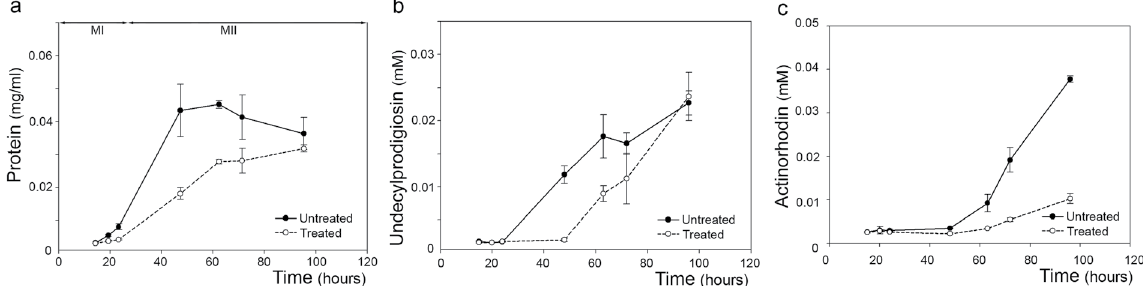
Figure 3. Effect of 5-aza-dC treatment in sucrose-free liquid R5A cultures. ( a ) Growth. ( b ) Undecylprodigiosin production. ( c ) Actinorhodin production. Continuous and dashed lines indicate the untreated and the treated culture,